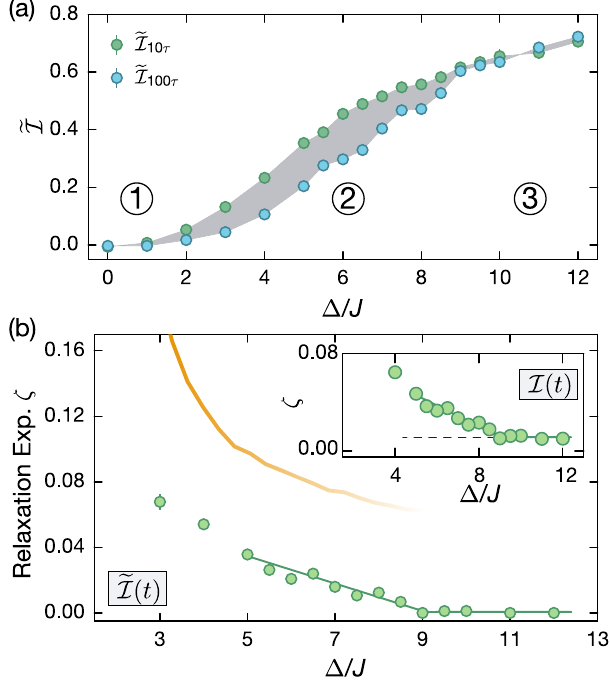
FIG. 3. Closed-system imbalance and relaxation exponents near the critical regime. (a) Closed-system imbalance short times ( 10 τ , green points) and at long times ( 100 τ , blue points) for fixed interaction strength of U ¼ 5 J . Three dynamical regimes can be identified: (1) a rapidly thermalizing regime at low disorder, (2) a regime of slow relaxation at intermediate disorder (visualized by the gray area), and (3) a regime at strong disorder in which relaxation is absent on experimentally accessible time scales, consistent with a many-body localized phase. (b) The relaxation exponent ζ obtained from Eq. (2) decreases contin- uously with increasing disorder until a threshold value Δ c , at which it vanishes (green points). A piecewise fit ζ ∝ fj Δ − ν ; 0 g for ζ in the regime Δ ∈ f 5 J; 12 J g yields Δ Δ c j 0 . 5 J as the critical disorder strength of the possible MBL transition. The yellow line is an approximate upper bound for the relaxation exponent. The inset shows the same analysis for I ð t Þ , i.e., neglecting the weak coupling to the environment. Apart from a small offset (dashed line) consistent with the known background coupling [40], we still find a sharp change of the extracted exponents at Δ c . Error bars denote the fit error and are typically smaller than the symbol